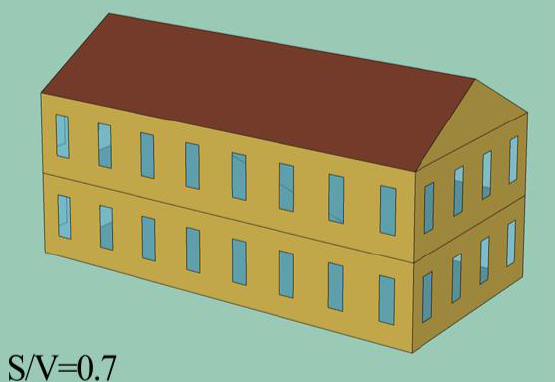
Figure 11. Typical models for optimization.